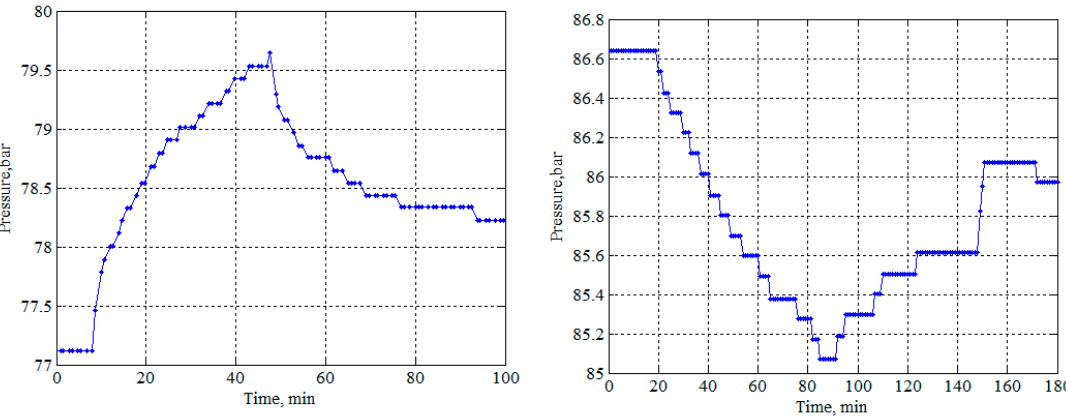
Figure 2. Fragments of the recording of pressure measurements plotted in MATLAB.